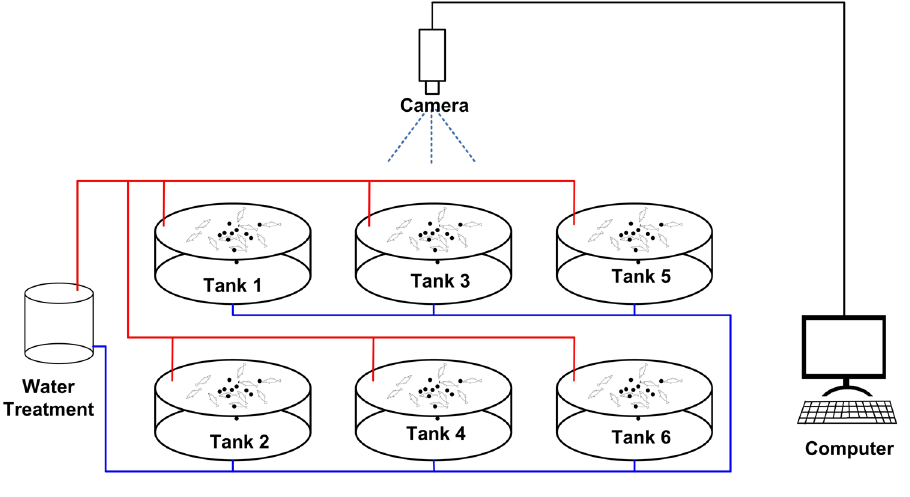
Figure 1. The experimental